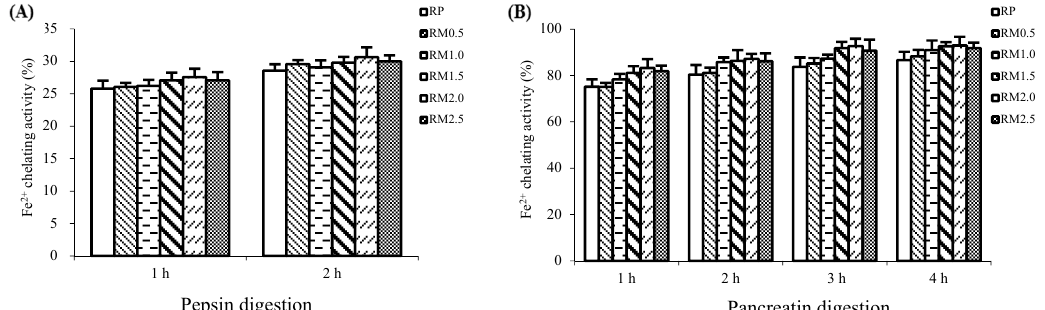
Figure 5. Fe 2+ chelating activities of rice protein (RP) and methionine added to rice protein (RM) hydrolysates during in vitro digestion with pepsin ( A ) and pancreatin ( B ). Values are the means ± SEM ( n = 3). * p < 0.05, in comparison with RP.